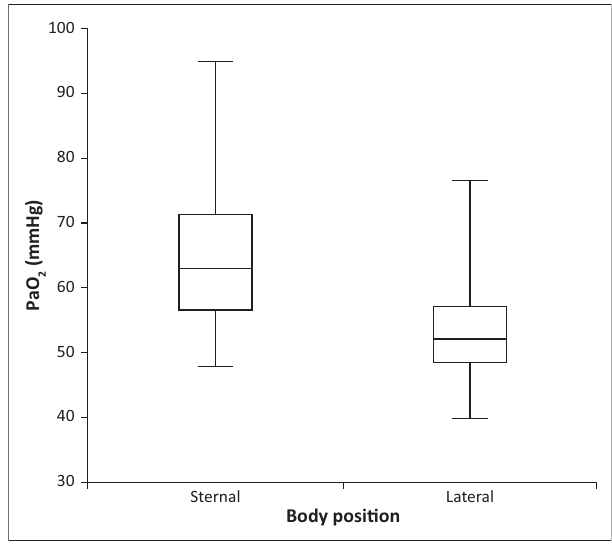
FIGURE 2: Box-plot showing partial pressure of arterial oxygen (PaO 25th and 75th quartiles, range) in 21 free-ranging black rhinoceroses during sternal ( n = 11) or lateral ( n = 10) recumbency at approximately 15 minutes after